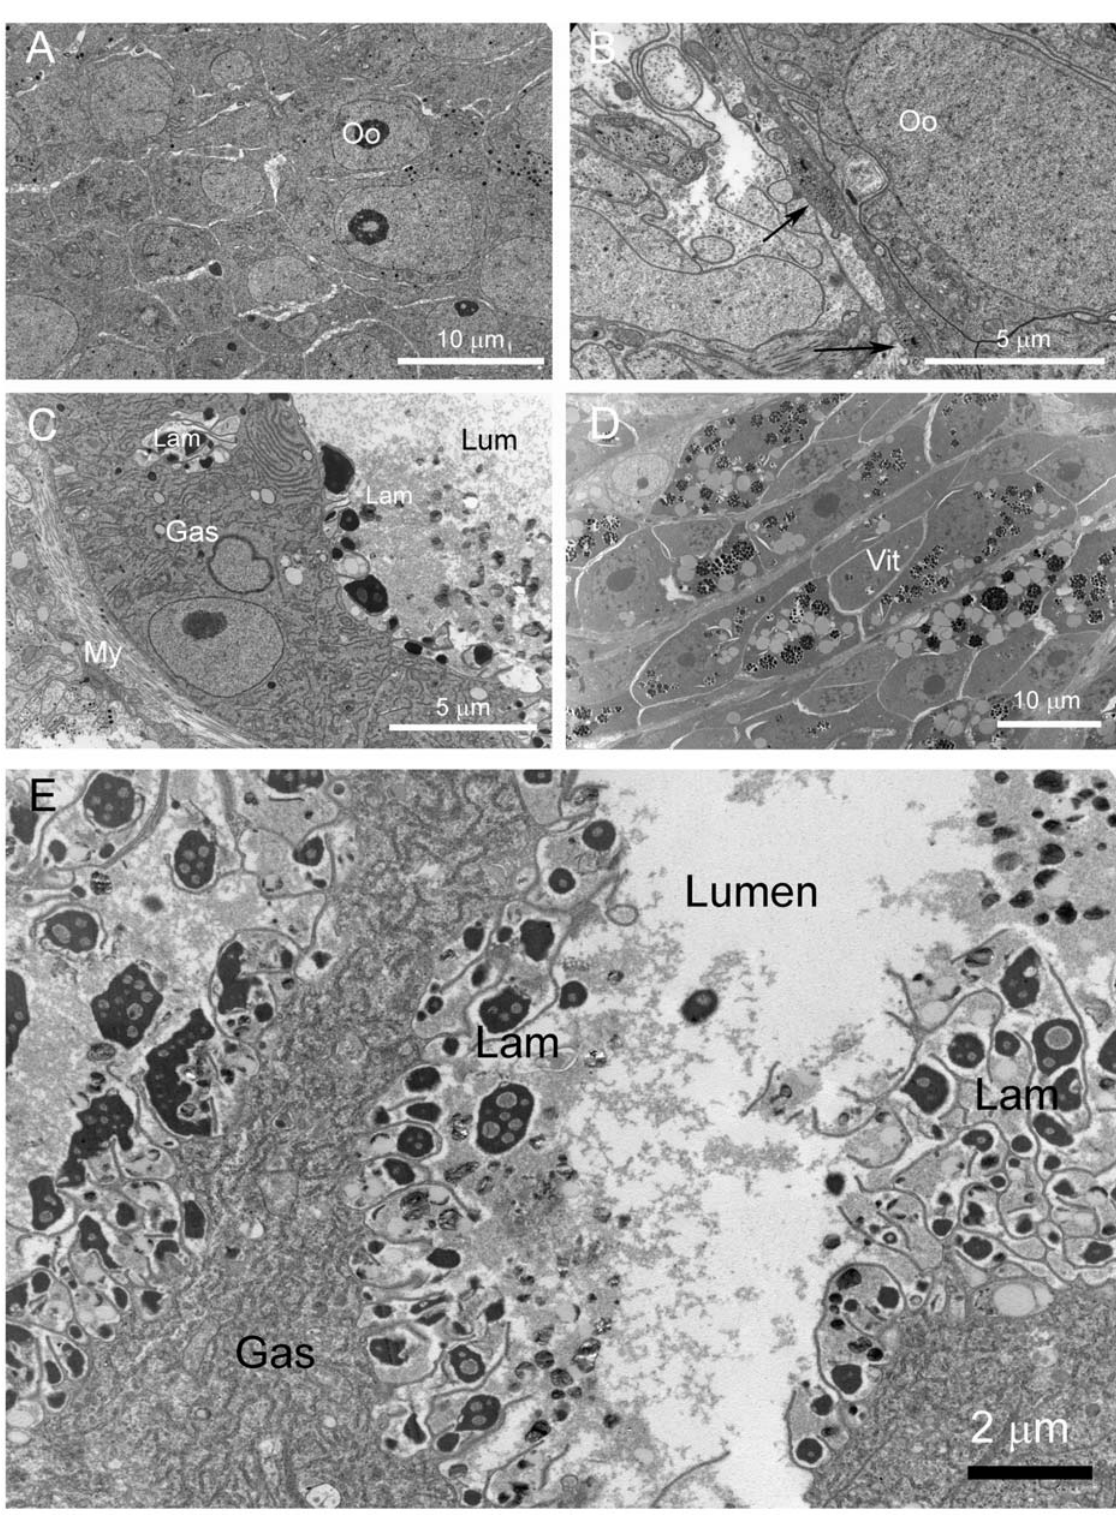
Figure 3. Ultrastructural morphology of microdissected tissues of female S.japonicum . (A) Ovary. Numerous oocytes with a high nuclear- cytoplasmic ratio are present as the sole cell type. (B). A thin cellular layer, incorporating myofibrils, is present as the limiting margin of the ovary. Arrow indicates margin of ovary. (C) Gastrodermis. The gastrodermis is a unilaminate syncytial layer forming the absorptive lining of the gut. (D). Vitelline cells. These accessory cells of the female reproductive system secrete egg-shell precursors and possibly yolk. Electron opaque lipid droplets are prominent features of this region. (E). Luminal surface of gastrodermis showing multiple stacked lamellae. Caption abbreviations; Gas=Gastrodermis epithelium, Lam=Lamellae, Lum=Lumen, My=Smooth muscle fibres, Oo=Oocyte, Vit=Vitelline